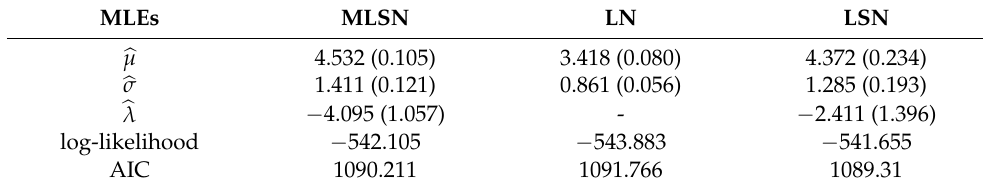
Table 4. MLEs for the MLSN, LN, and LSN models.